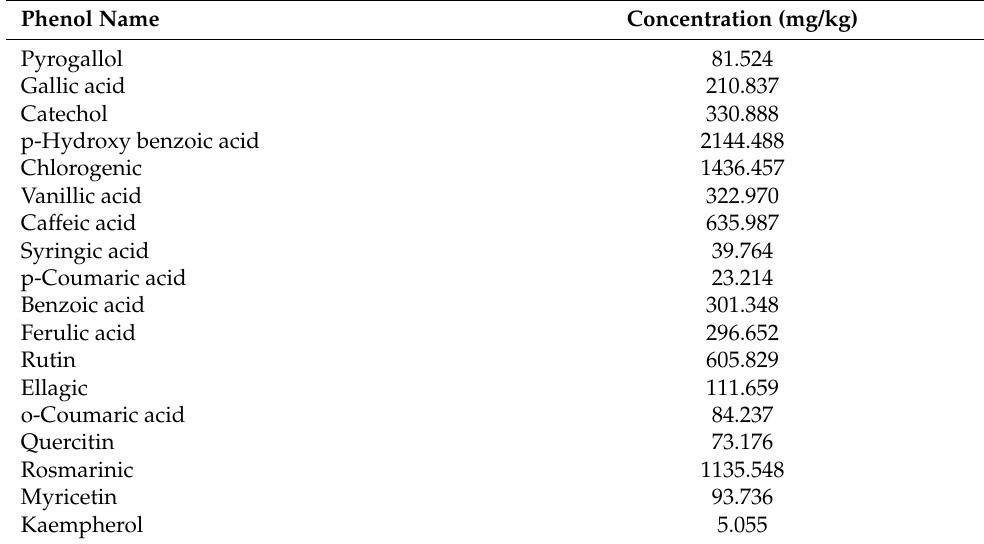
Table 1. Colocynth seed phenolic compounds profile separated and identified by